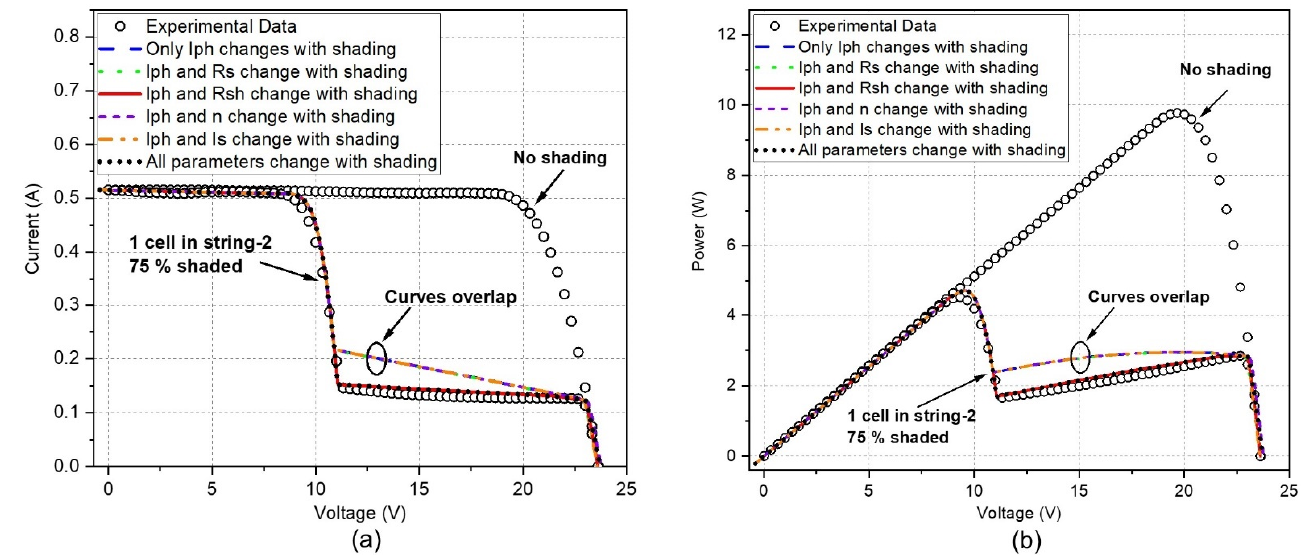
Figure 9. Experimental and calculated I-V and P-V curves of the 10 W PV module at the non-shading and under 75% of shading on a single cell. The simulation was carried out by considering the parameter variation with shading for six cases listed in Table 3: ( a ) I-V curves; ( b ) P-V curves. Each experimental curve is the average of three measurements under a light irradiance of 1000 W/m² measured at the centre of the module at a module temperature of 25 °C.